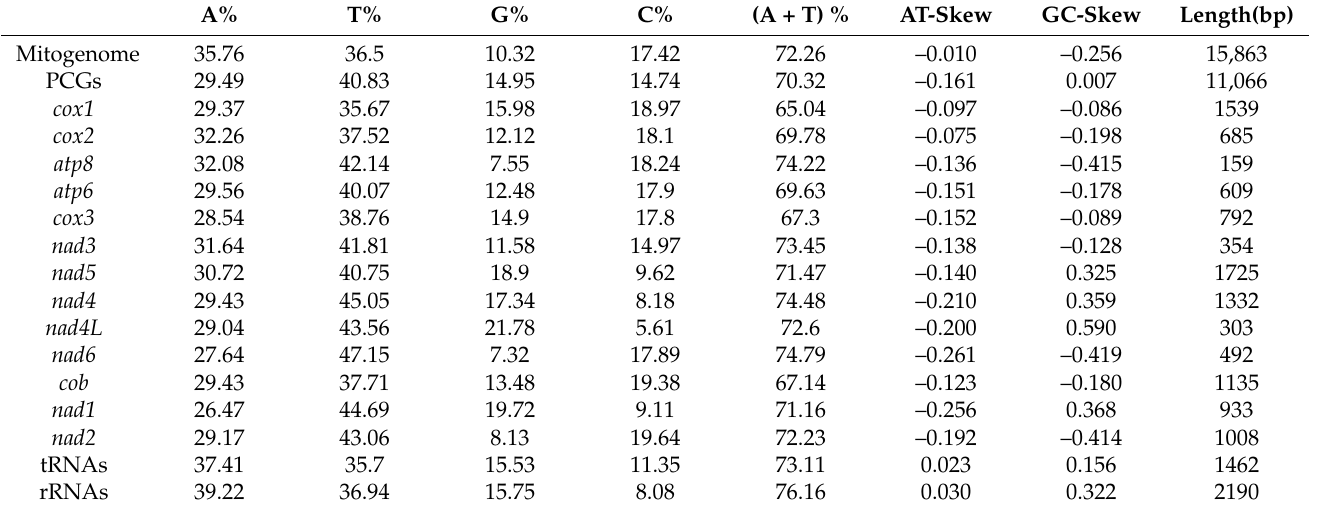
Table 2. Composition and skewness of P. makianus